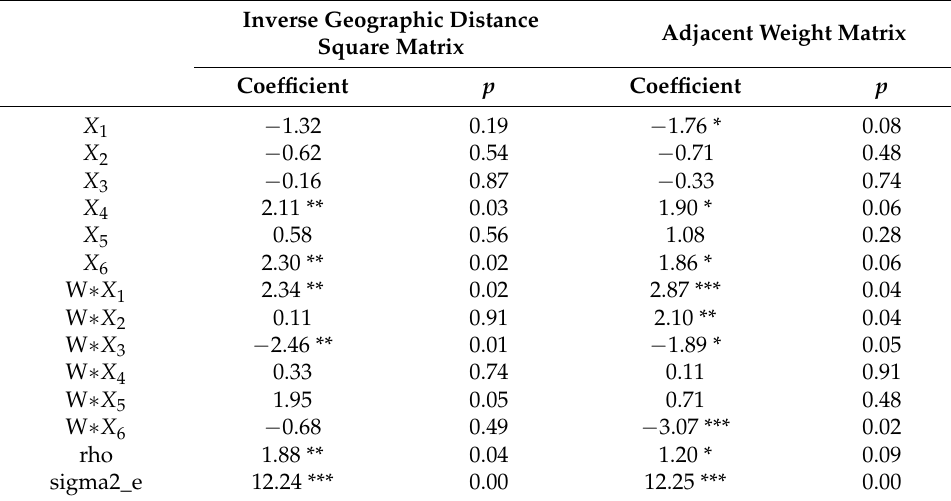
Table 13. Model estimation results under different weight matrices. Inverse Geographic Distance Adjacent Weight Matrix Square Matrix Coefficient p Coefficient p X 1 − 1.32 0.19 − 1.76 * 0.08 X 2 − 0.62 0.54 − 0.71 0.48